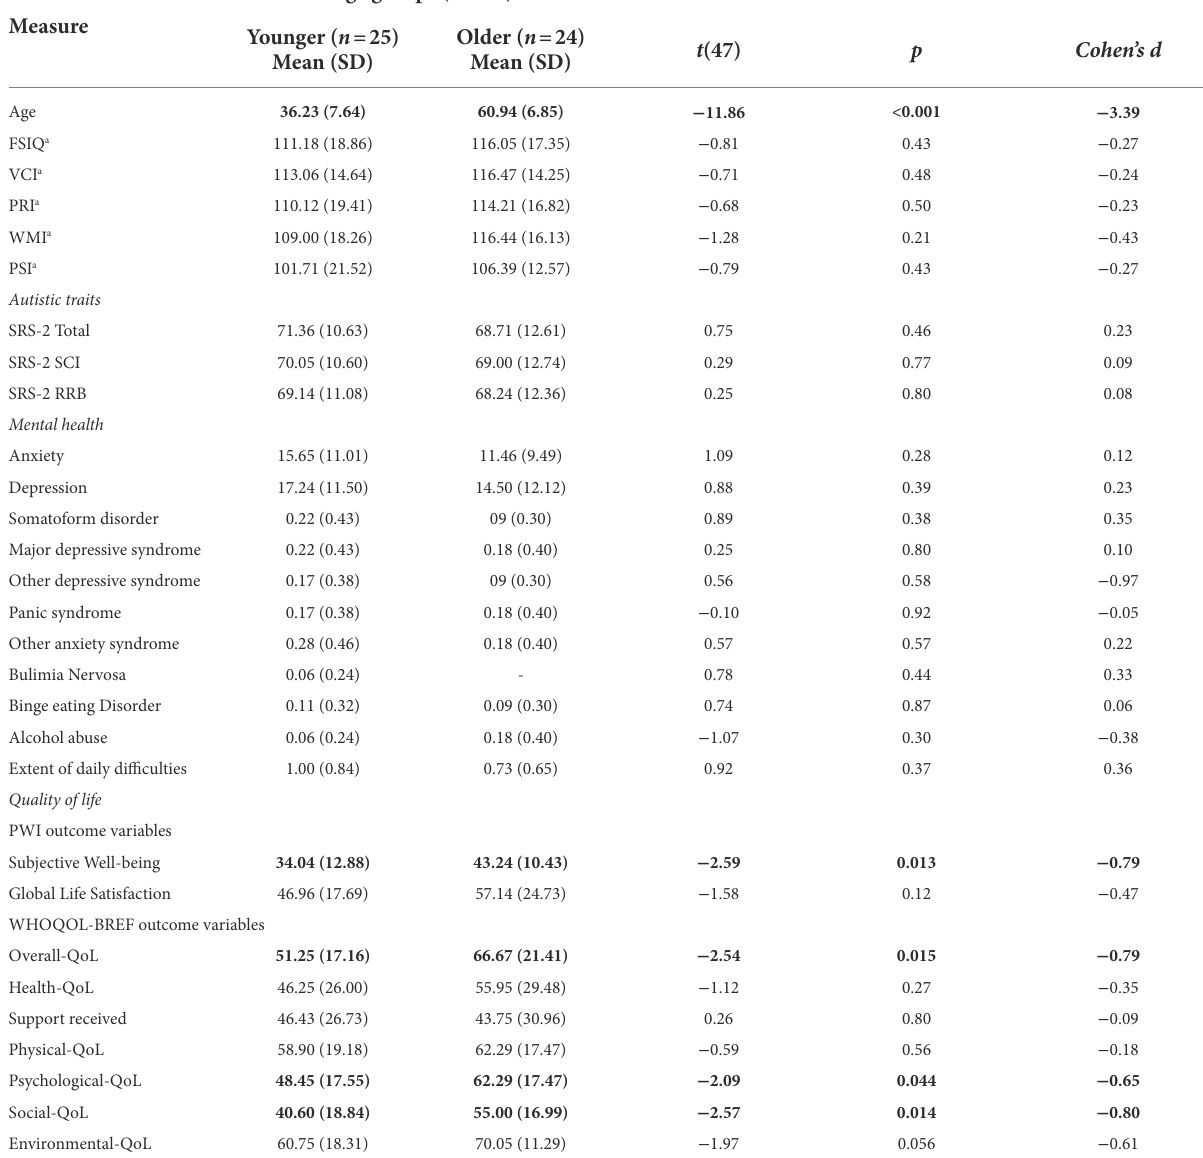
TABLE 2 T2 age-group comparisons of autistic traits, mental health, and